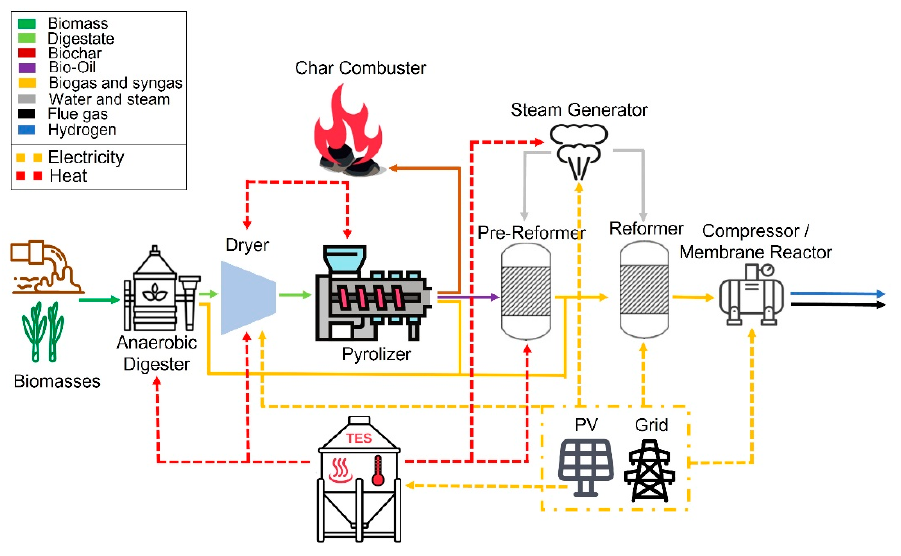
Figure 1. Plant mass and energy flows.